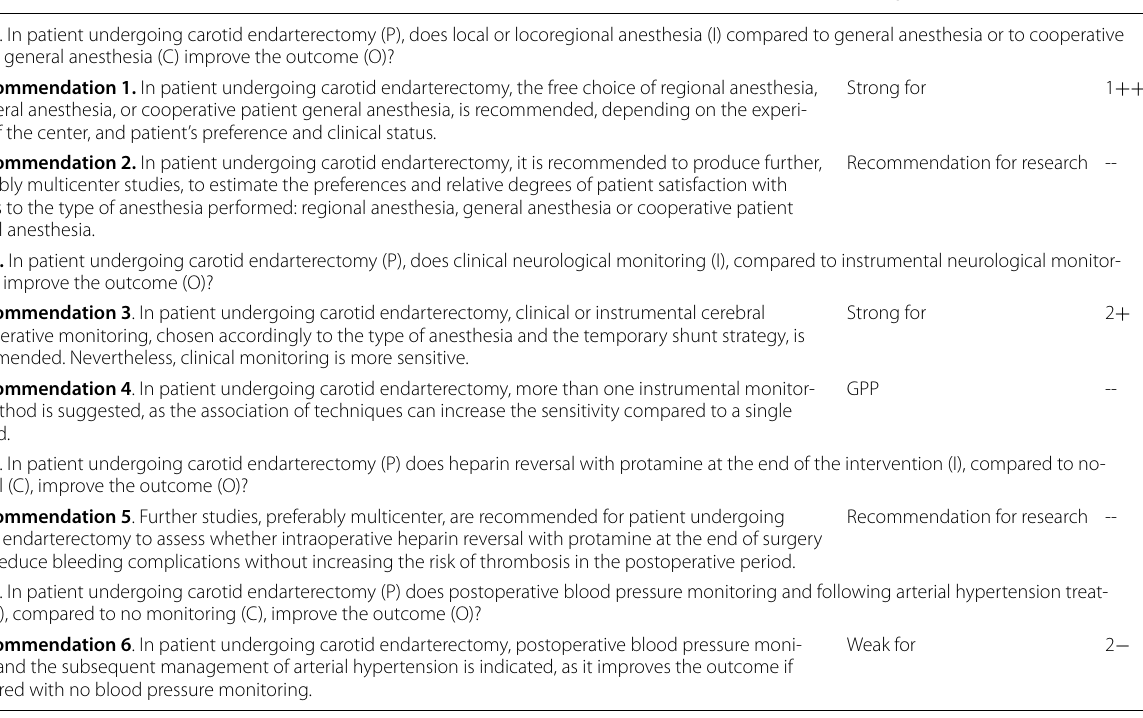
Table 4 PICO questions and